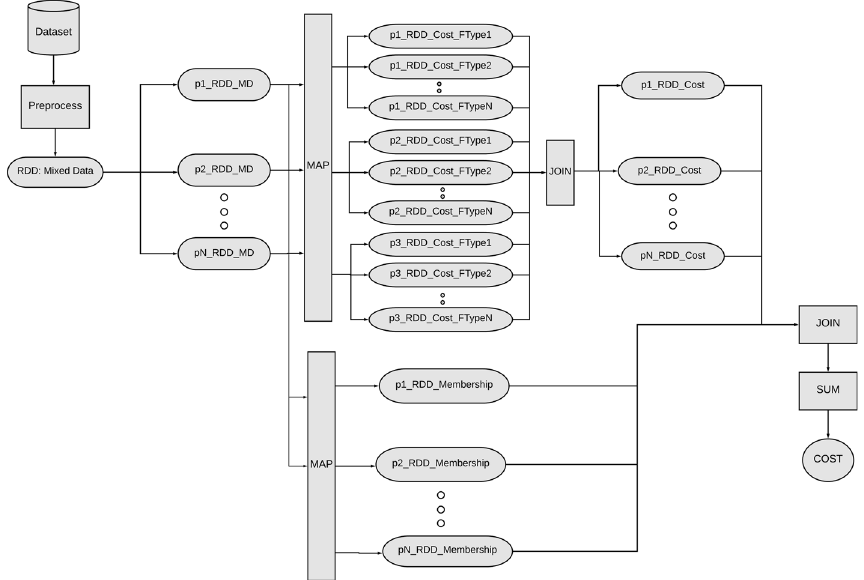
Fig. 2 Distributed